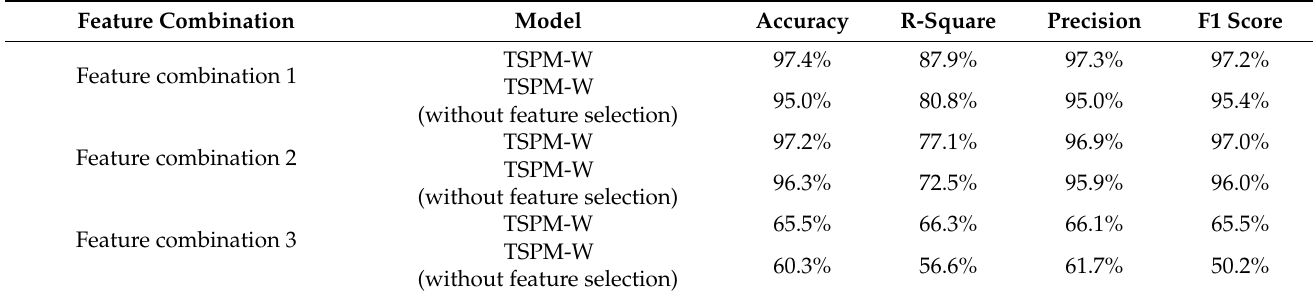
Table 6. Feature selection comparison experiment